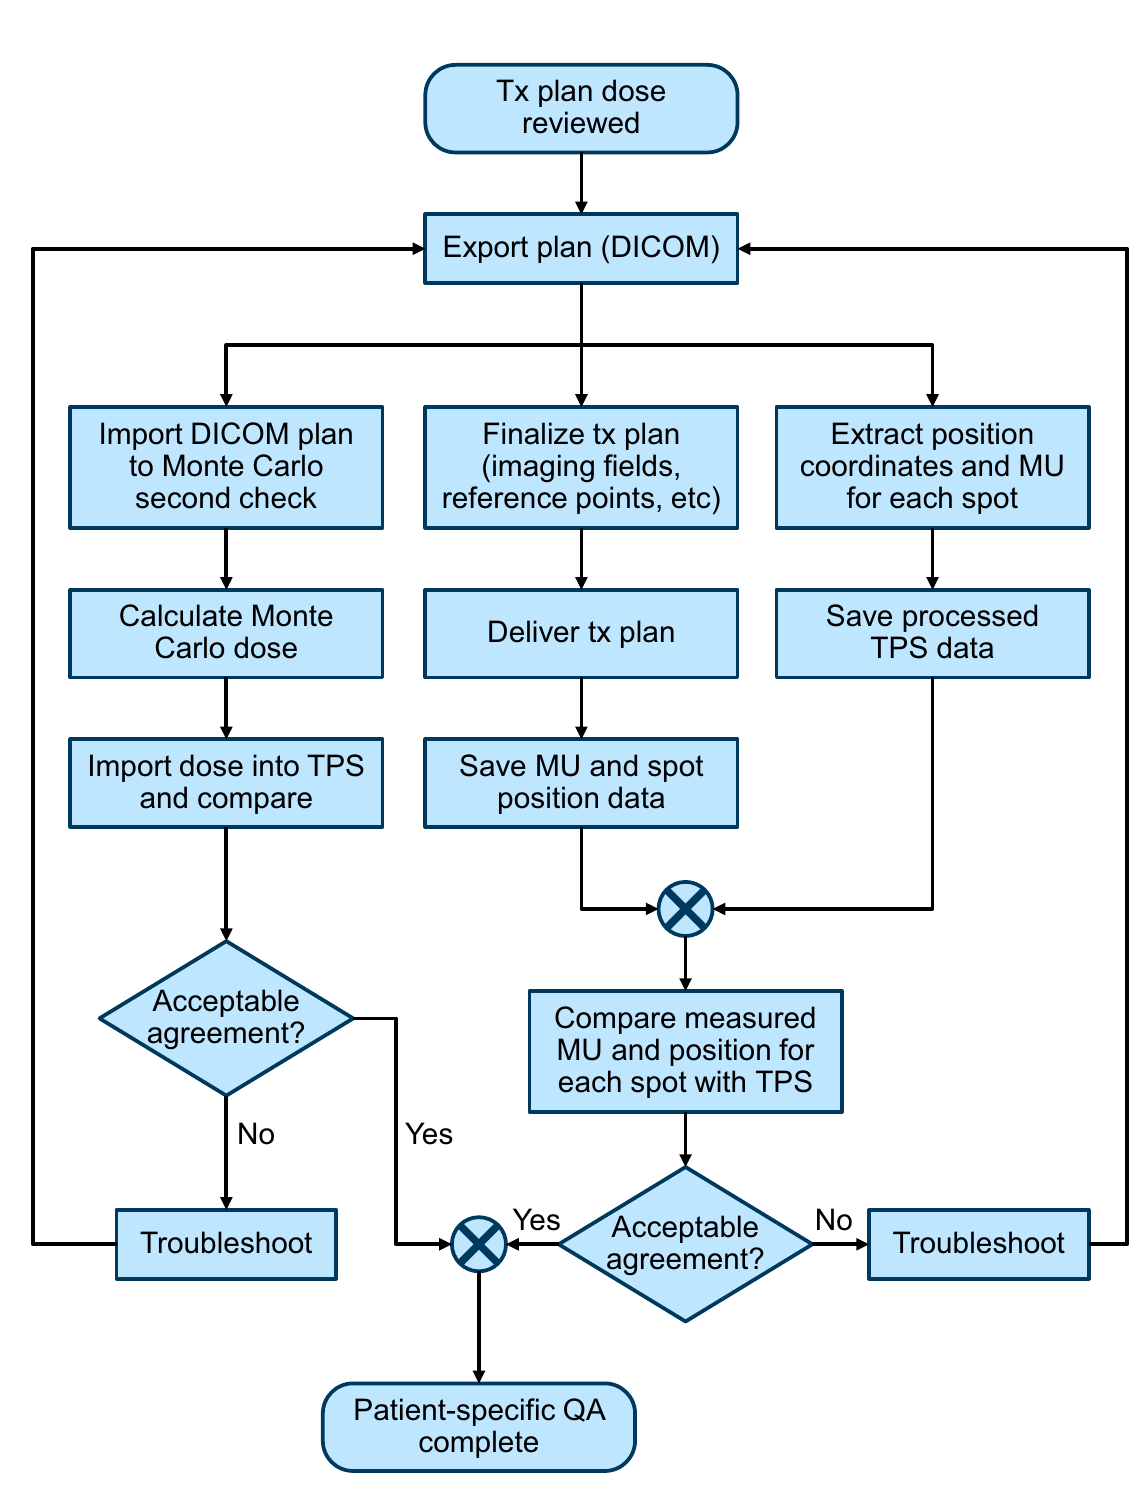
Fig 1. Process diagram for proton patient-specific QA. Independent checks of the dose calculation and treatment delivery system are both vital components of the process.